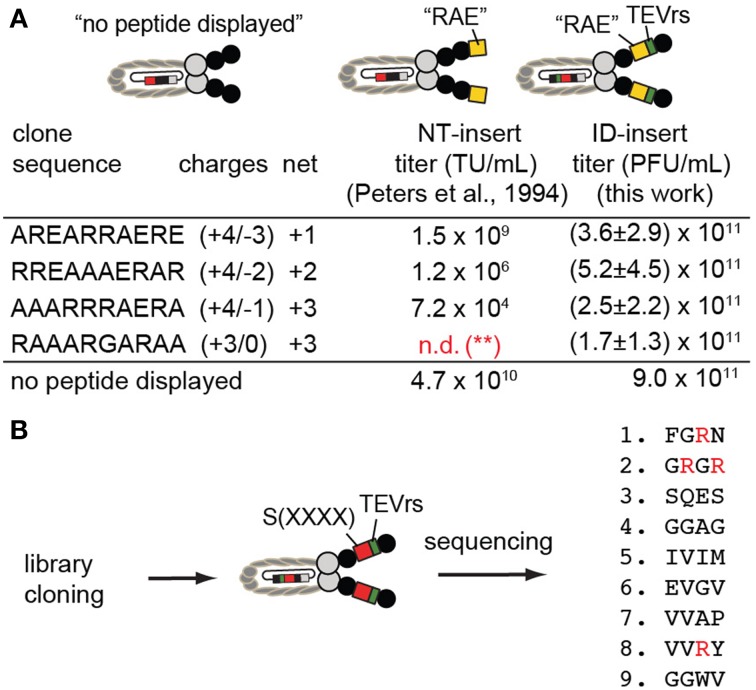
(A) ID-PhD enhances the expression of positively charged peptide sequences. The data in “NT-insert”-column has been acquired by Dower and co-workers (Peters et al., 1994); it shows that Arg-rich “RAE”-sequences, when expressed at the N-terminus (NT) of pIII, impede phage titer by 2–6 orders of magnitude (TU = transducing units). We demonstrated that phage clones that display these sequences in the ID-format do not exhibit diminished titers; they are similar to the titer exhibited by phage without an insert (control phage labeled as “no peptide displayed”). Note that in experiments by Peters et al. (1994), control phage is FdTet phage displaying no N-terminal sequence. In our experiments, control phage is M13KE phage without ID-insert. The data is average and standard deviation from titer in three independent experiments. (**): n.d., not determined; (B) We expressed the library of random tetrapeptides in ID-PhD format and, in preliminary low-throughput sequencing, observed a significant fraction of peptides with Arg. Abundance of Arg can be further validated in this library using next-generation sequencing.